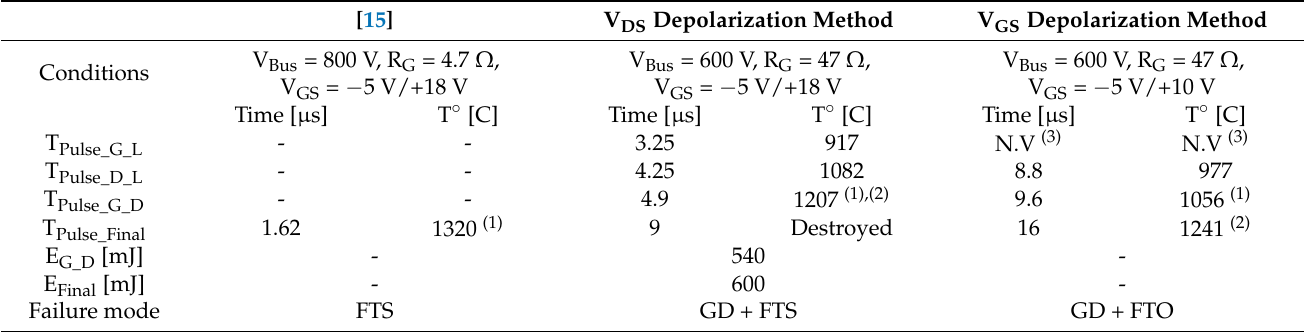
Table 2. Average key parameters between V DS and V GS depolarization compared to nominal operating conditions